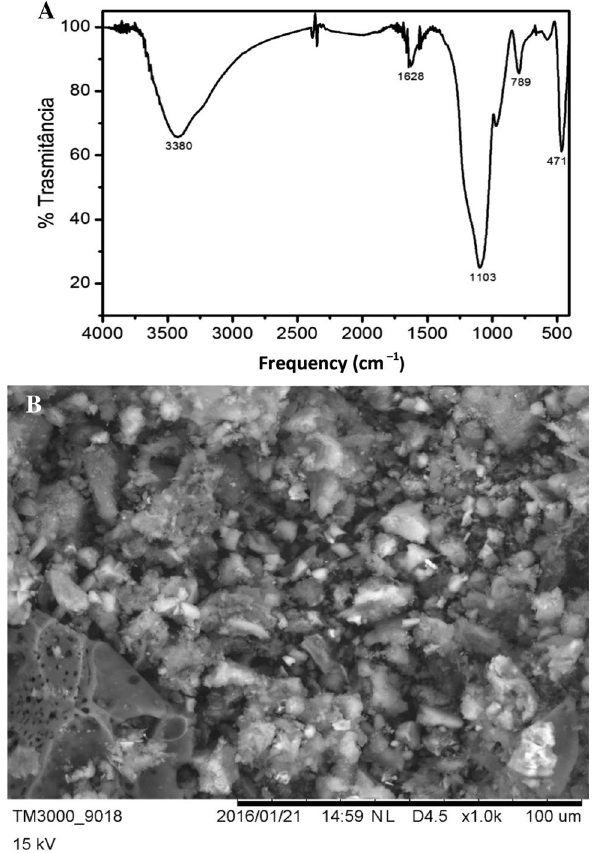
Fig. 2 The FTIR spectrum (a) and SEM micrograph (b) of APC-1.0